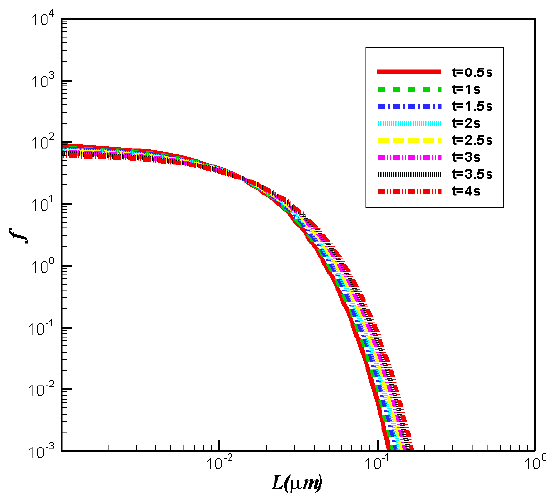
Figure 5. Evolution of CSD obtained using the Chebyshev spectral collocation method.